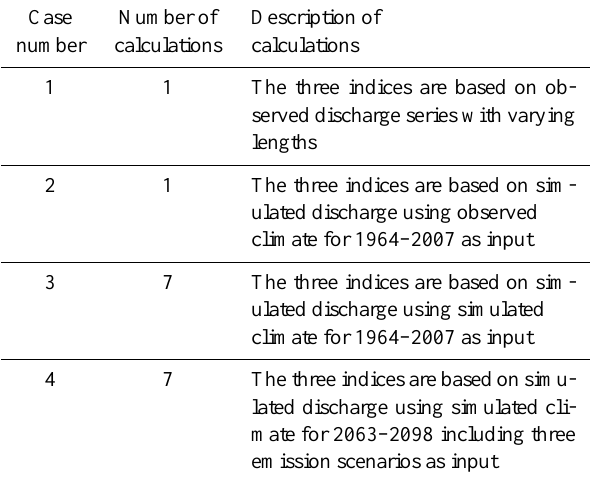
Table 1. Overview of the seasonality